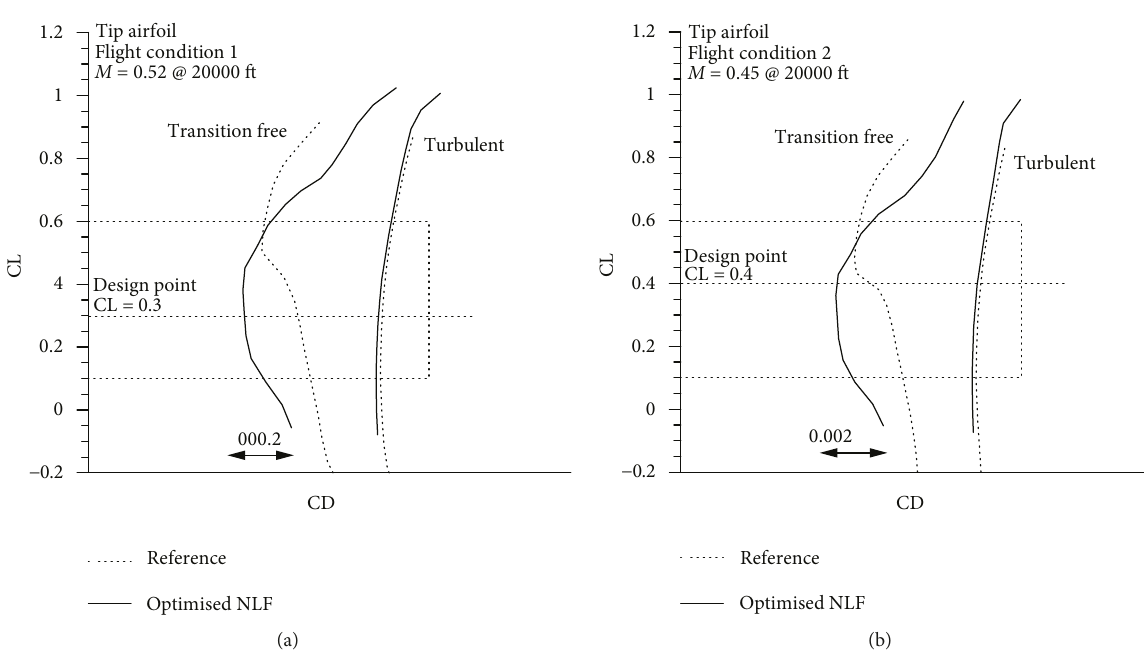
Figure 7: Computed 2D performance of optimized tip